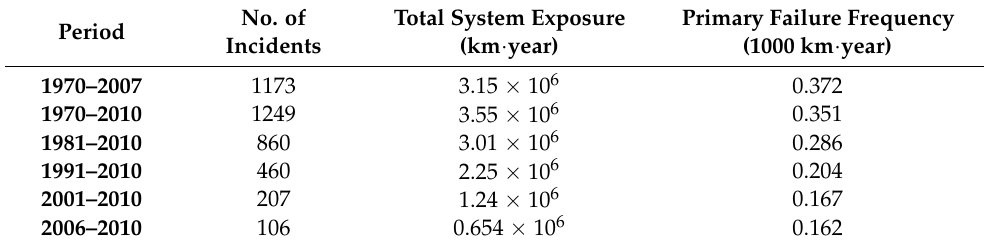
Table 5. Primary gas pipeline failure frequency.